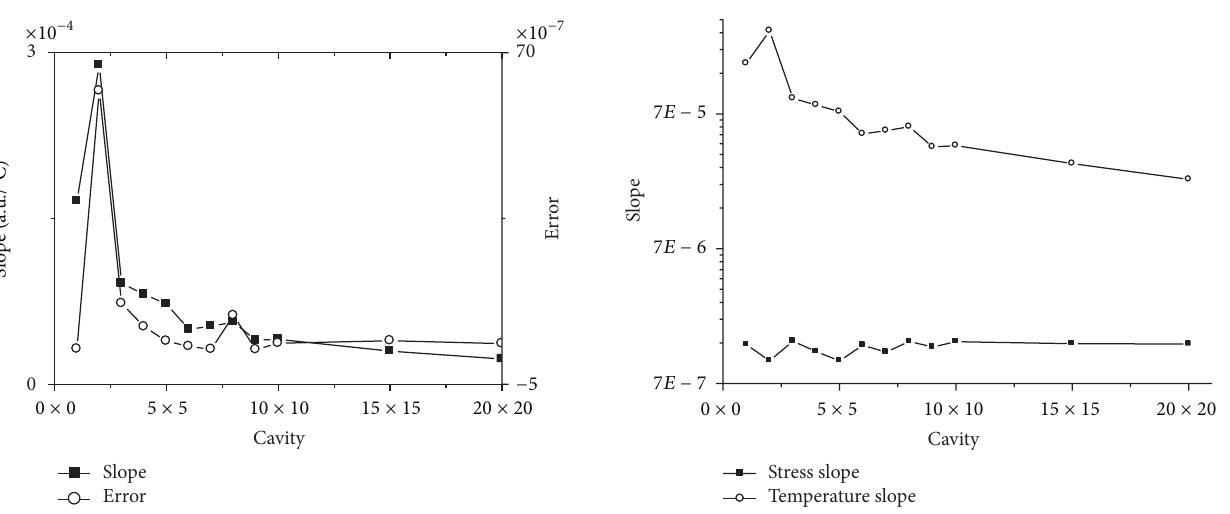
Figure 8: The slope and its error of the linear fitted curves for the resonant frequency changing with temperature which has the biggest average normalized power spectrum.